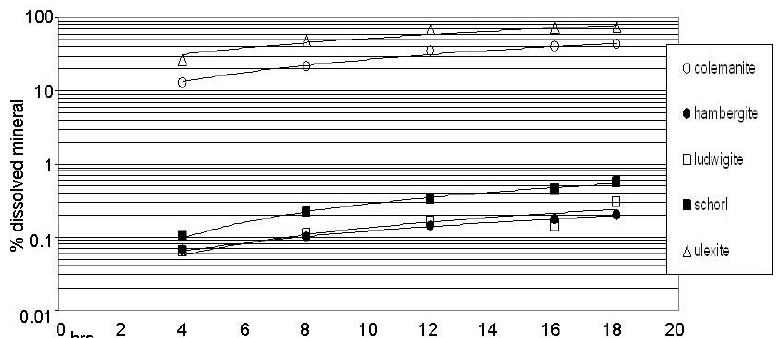
Figure 1. Boron release in